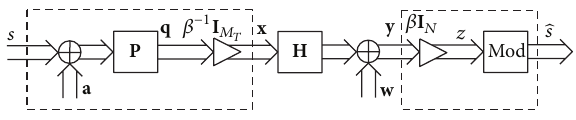
Figure 1: Block diagram of a VP